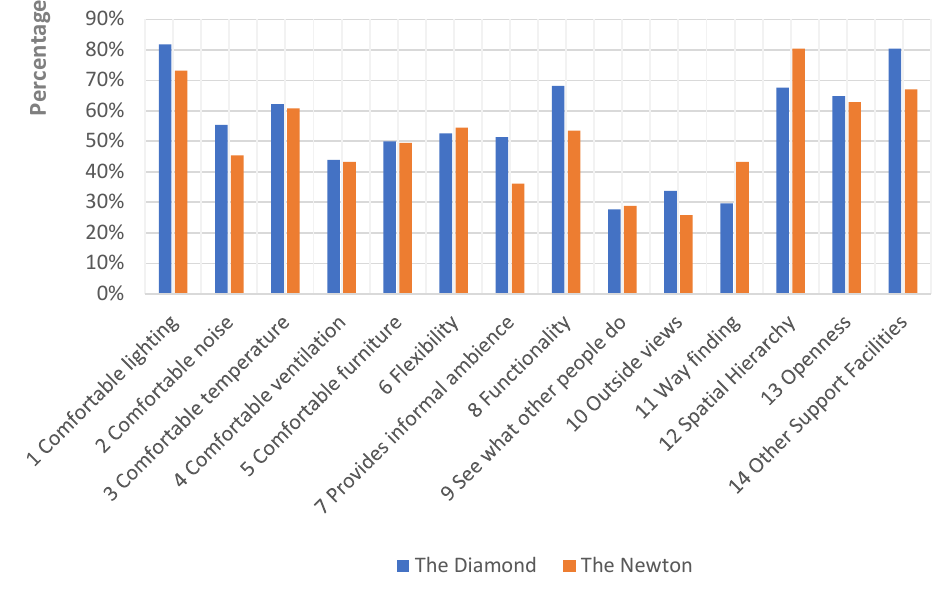
The Diamond The Newton Reasons for selecting and using the informal learning spaces Figure 7. Percentage of 14 reasons for selecting and using informal learning spaces of Diamond and Newton, from questionnaire.